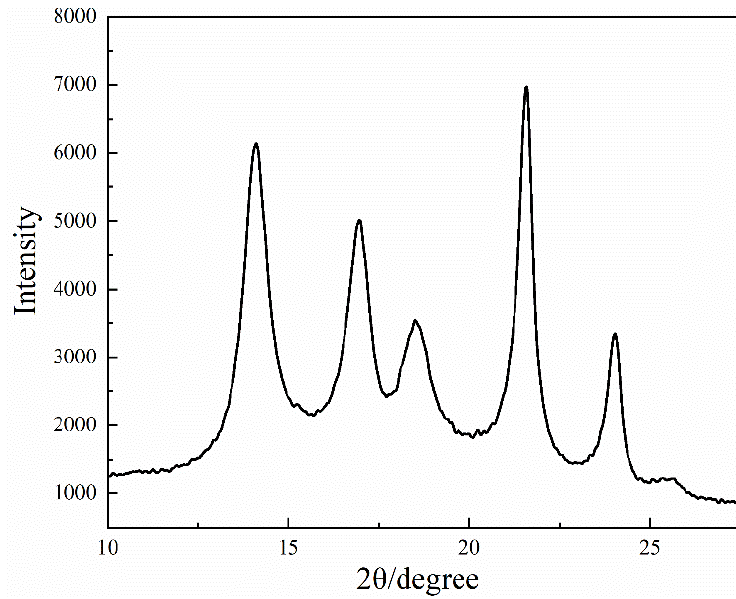
Figure 5. XRD curve of the PCTF.